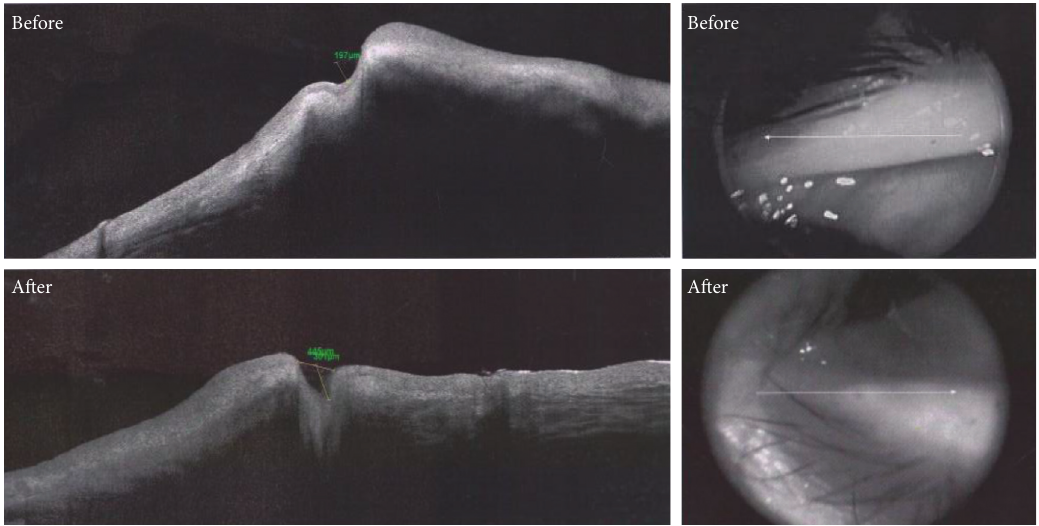
Figure 2: Case 1: OCT punctal changes before and after treatment.